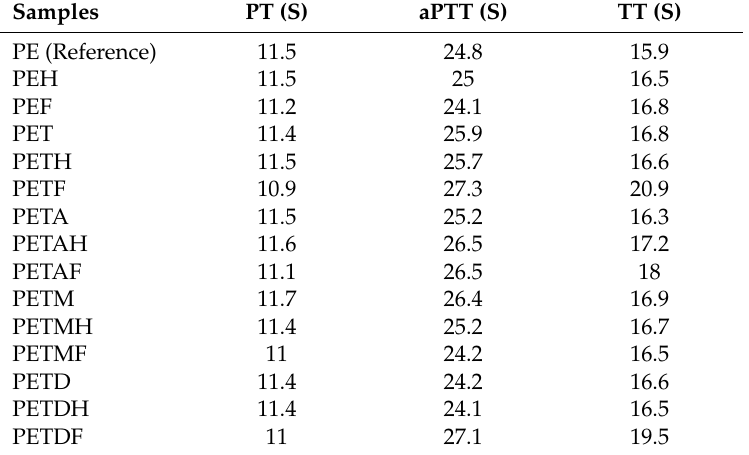
Table 3. Antithrombotic test results. PT: Prothrombin time; aPTT: activated partial thromboplastin time; TT: Thrombin